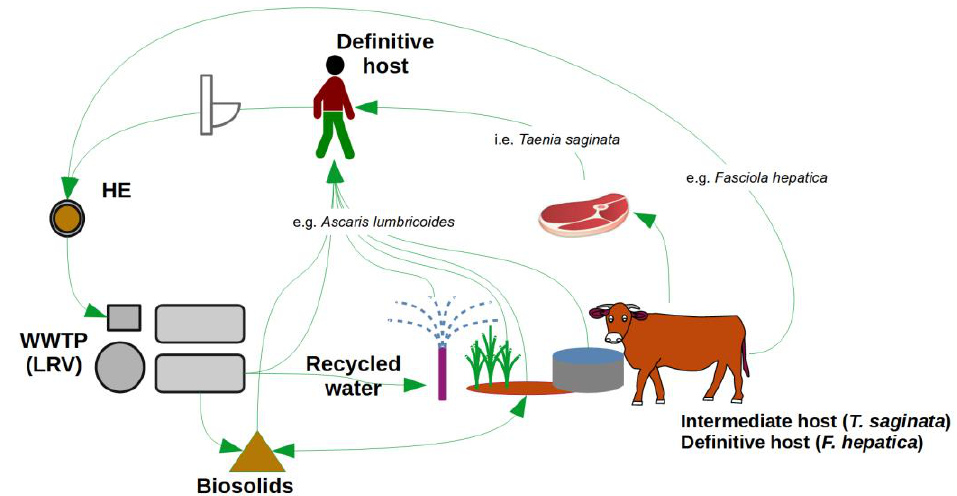
Figure 1. Examples of major routes of transmission of helminth egg (HE) relevant to the protection of human and stock health from sewage treatment; WWTP — wastewater treatment plant, the intermediate host for F. hepatica (snails) are not shown.